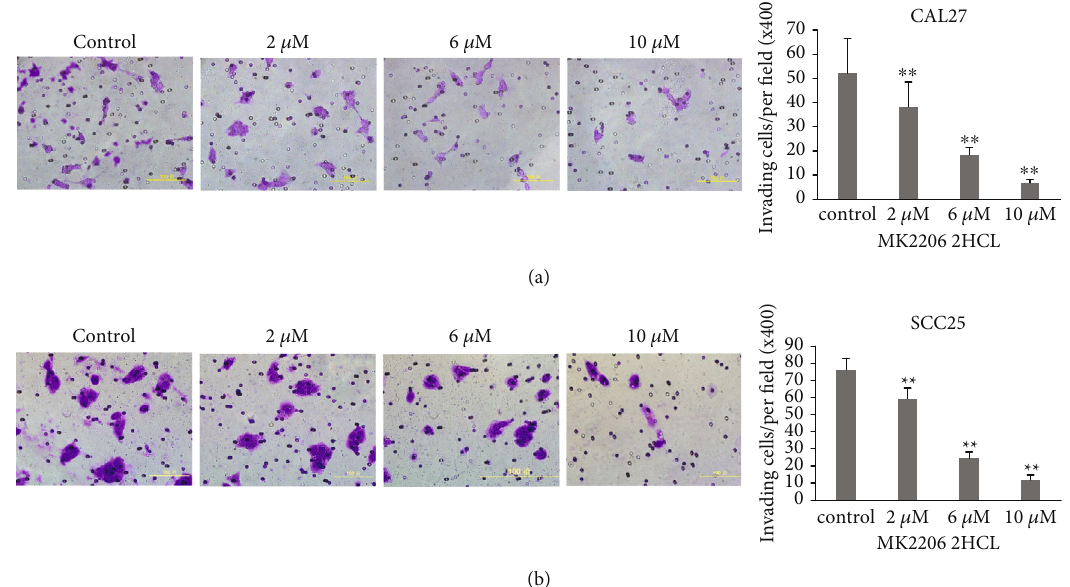
Figure 10: MK2206 2HCl suppressed the OSCC cell invasion ability. (a) MK2206 2HCl inhibited CAL27 cell invasive ability by Transwell invasion assay. (b) MK2206 2HCl inhibited SCC25 cell invasive ability by Transwell invasion assay. All data are presented as the mean ± SD : ∗∗ P < 0 : 01 as compared with the control group. Magni fi cation ×